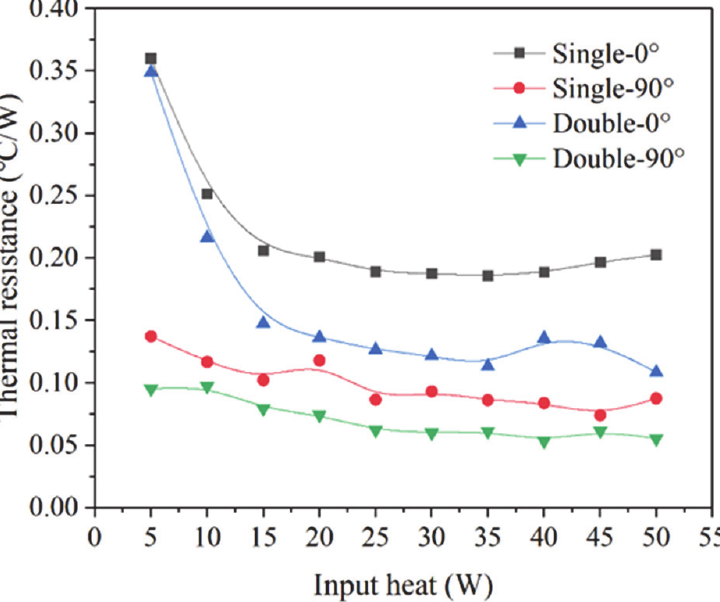
Figure 7. The thermal resistance of the SSD heat sink under different heat inputs.